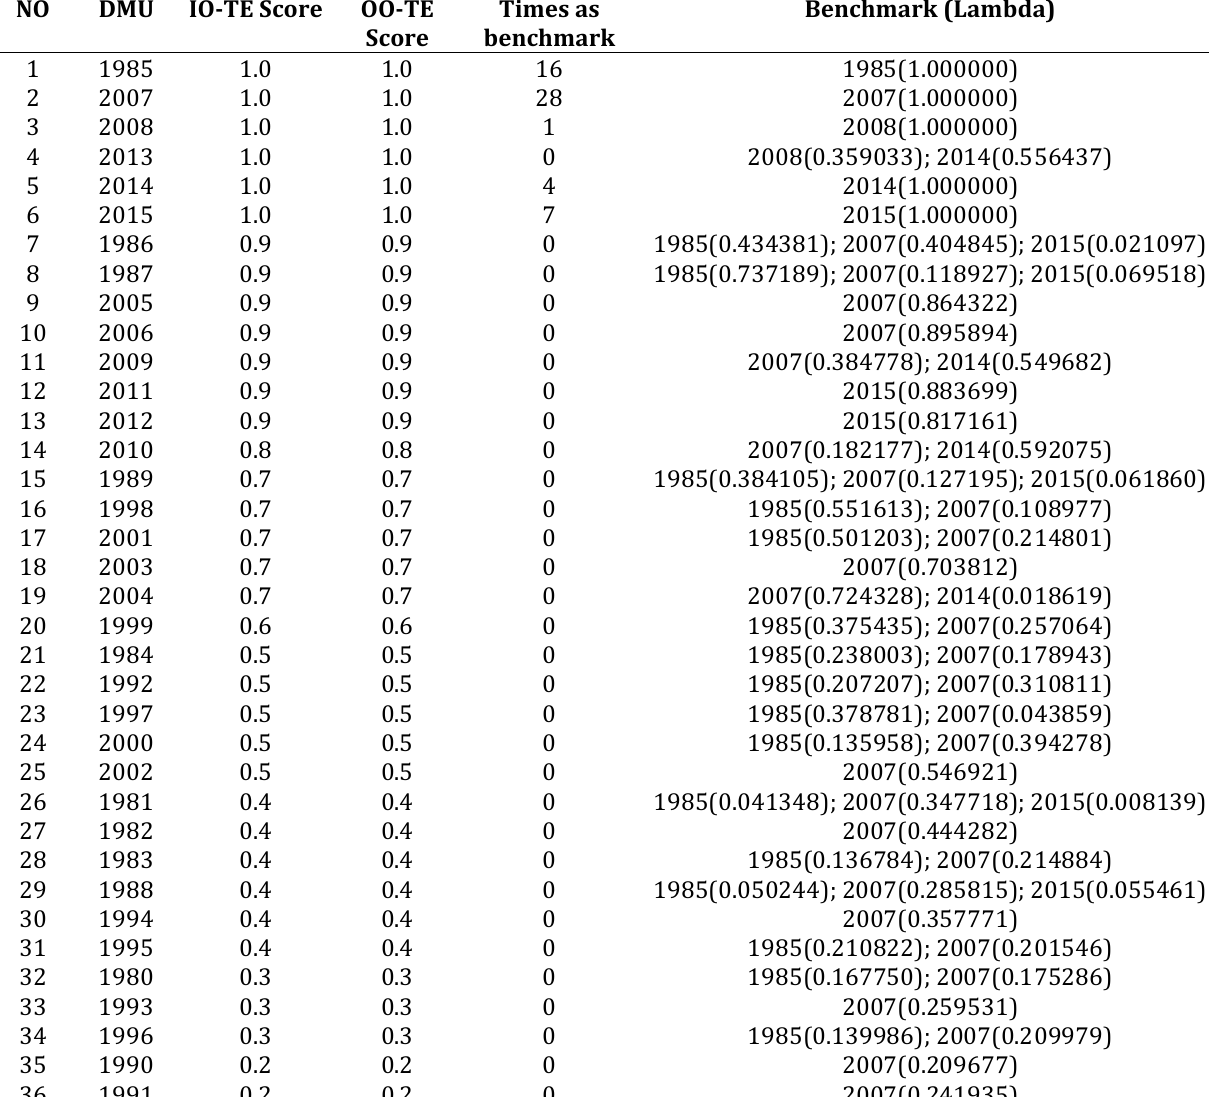
Table 10: Input-Oriented Technical Efficiency Benchmarking for Calabar Port